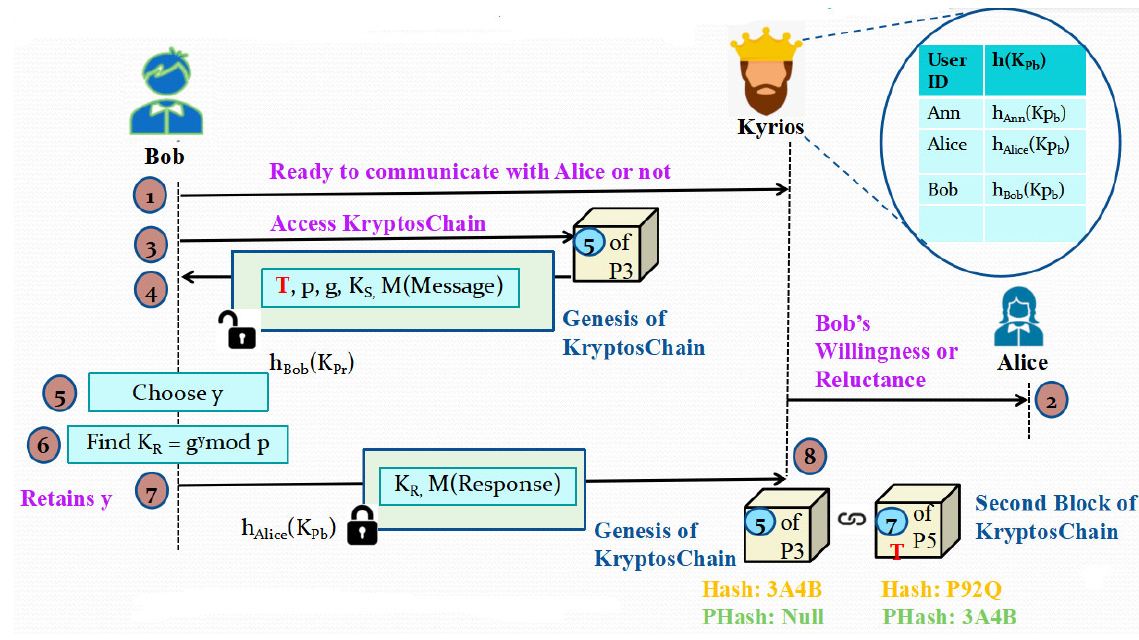
Figure 6. Illustration of Phase 5: Second Block Generation Process.